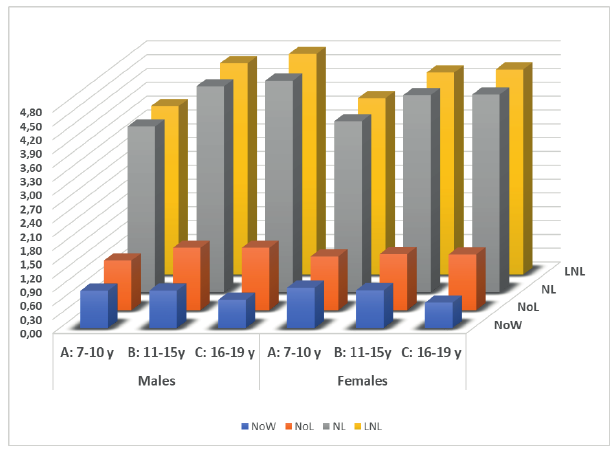
Figure 2. Growth dependence of main anthropometric parameters in males and females. NoW, nostril width; NoL, nostril length; NL, nasal length; LNL, lateral nasal length.